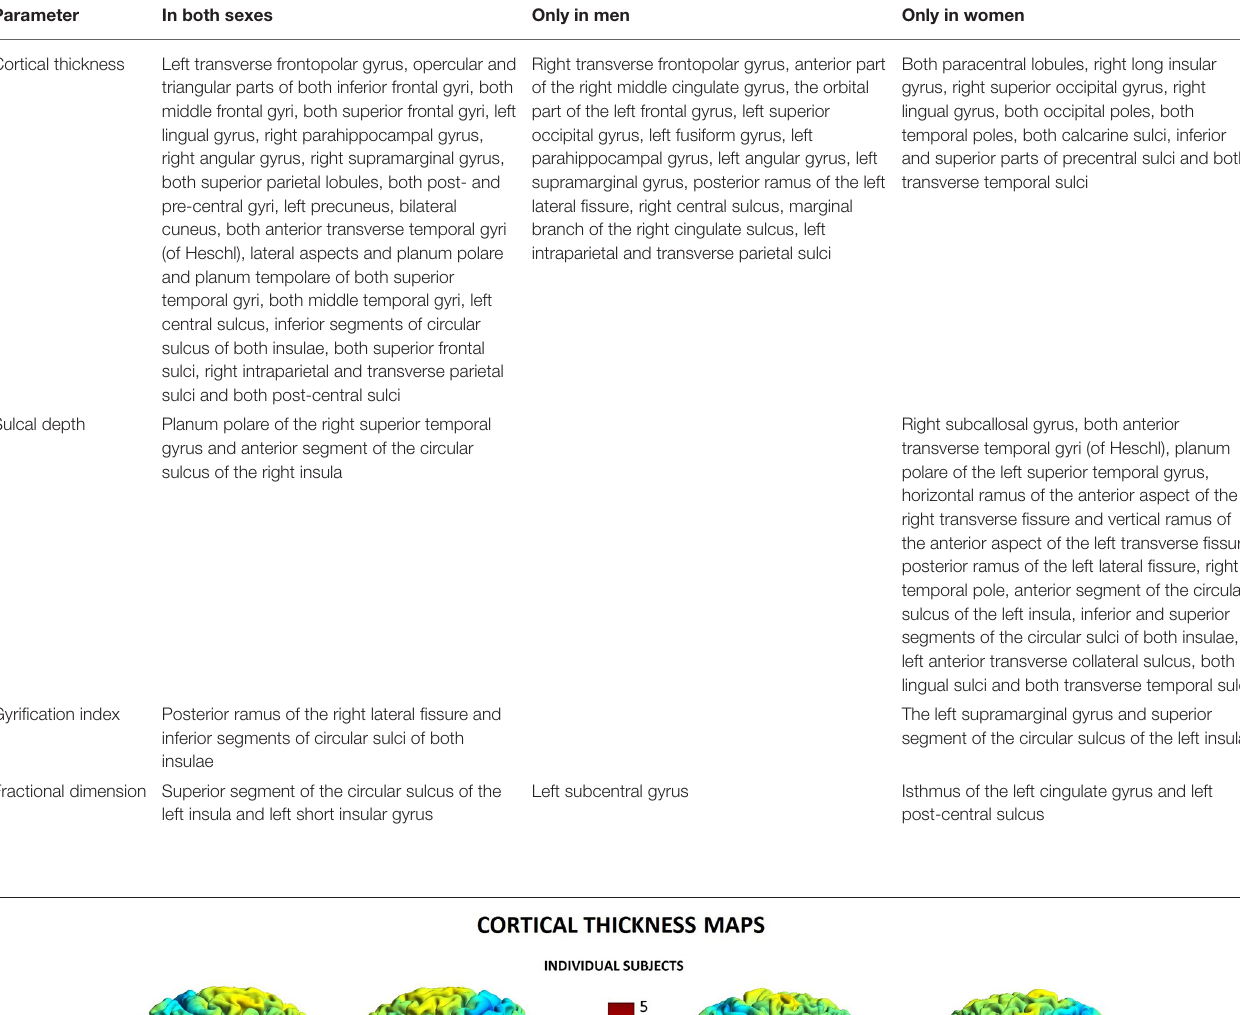
TABLE 5 | Detailed list of locations showing significant changes during aging in both sexes and only in men or women. Parameter